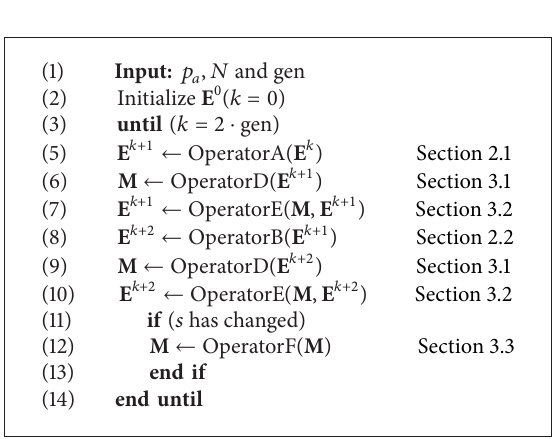
Algorithm 3: Multimodal cuckoo search (MCS)